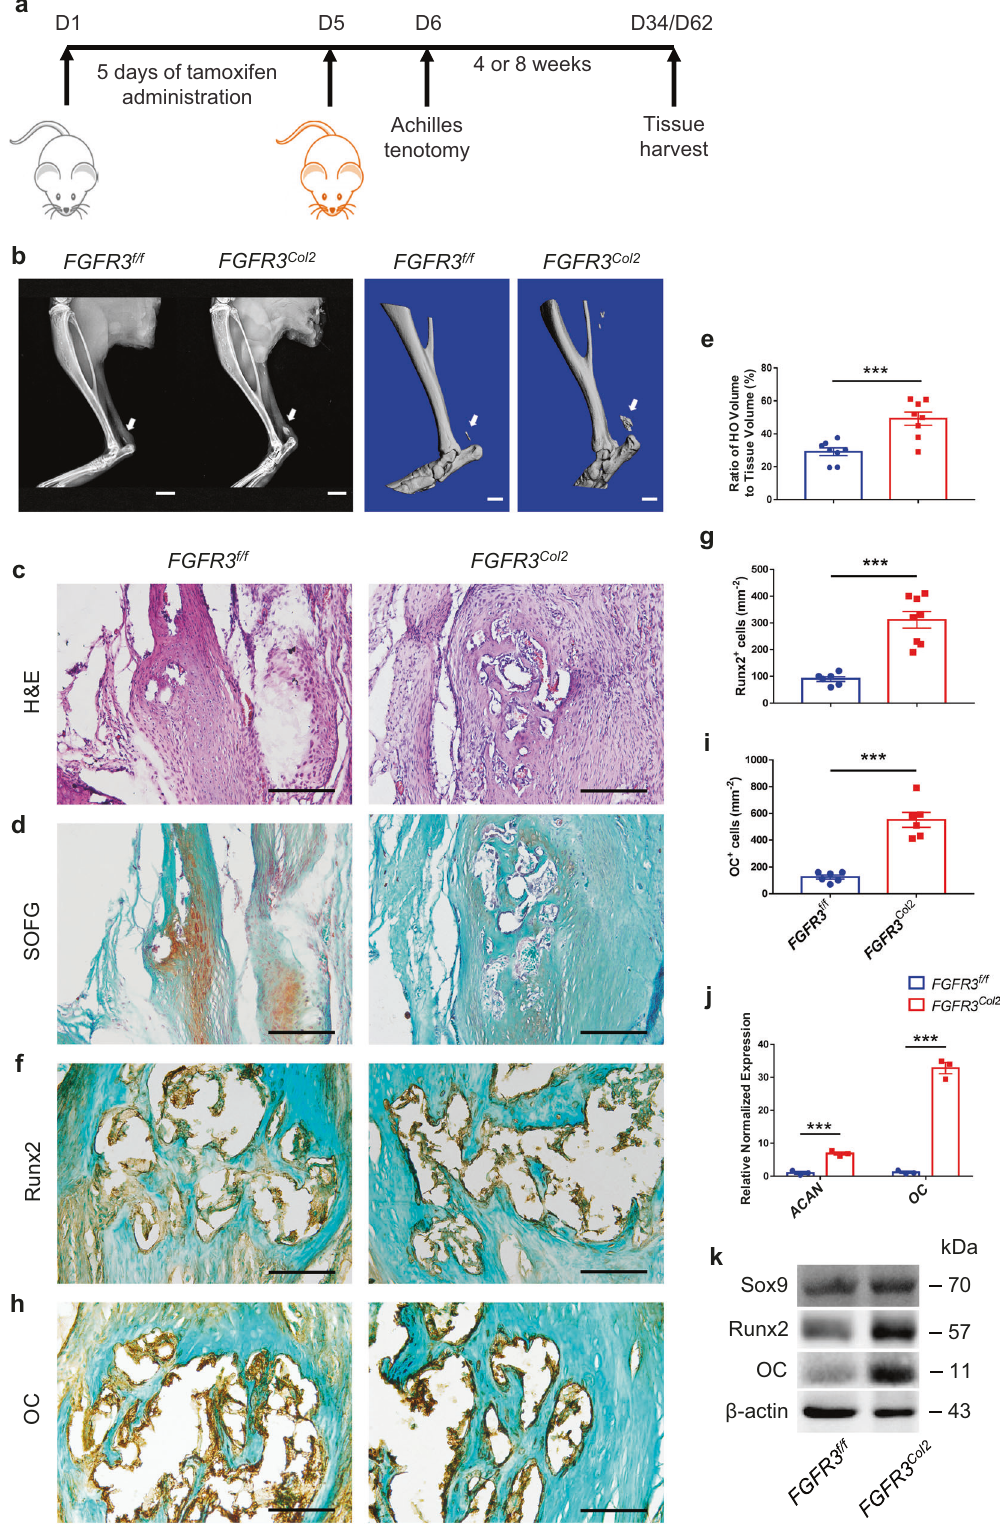
FGFR3 Col2 mice relative to that of the controls (Supplementary Fig. 1e-h). Furthermore, quantitative PCR and western blot demonstrated that the expressions of chondrogenic markers aggrecan (ACAN) and Sox9, as well as the osteogenic marker Cbfa1/Runx2 in the Achilles tendon were signi fi cantly higher in